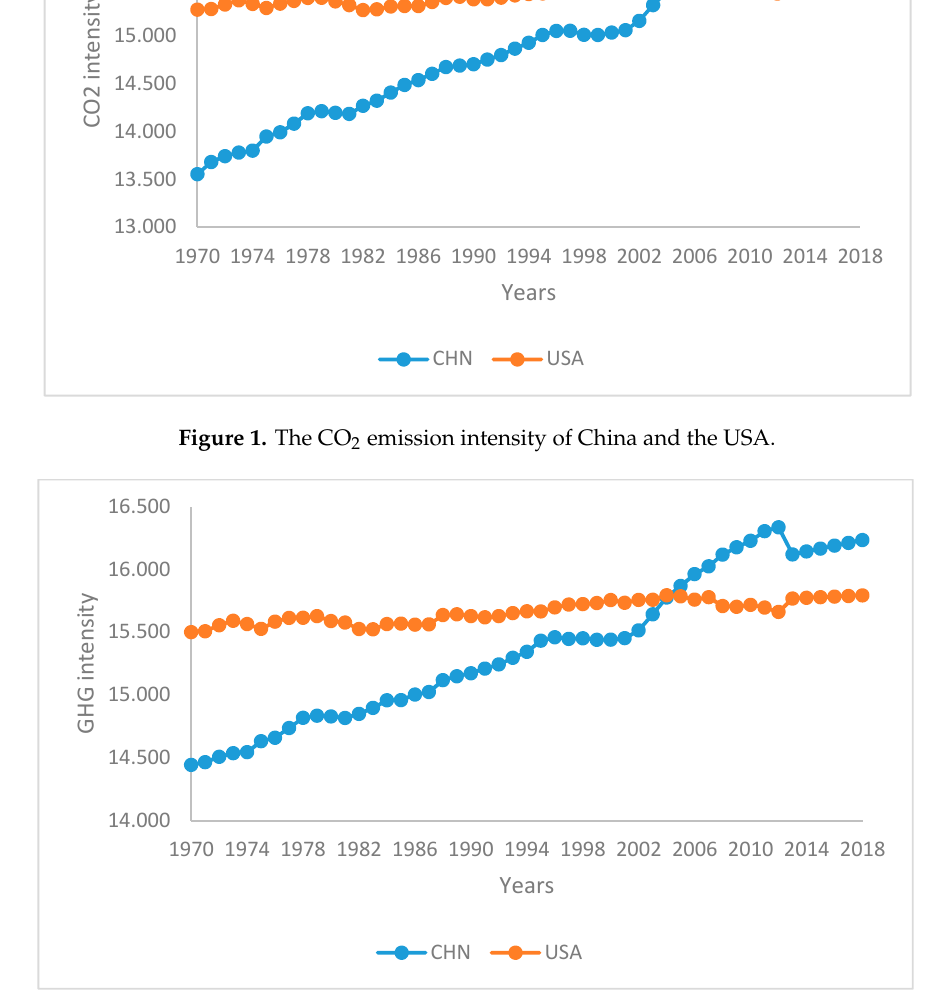
Figure 2. The GHG emission intensity of China and the USA.